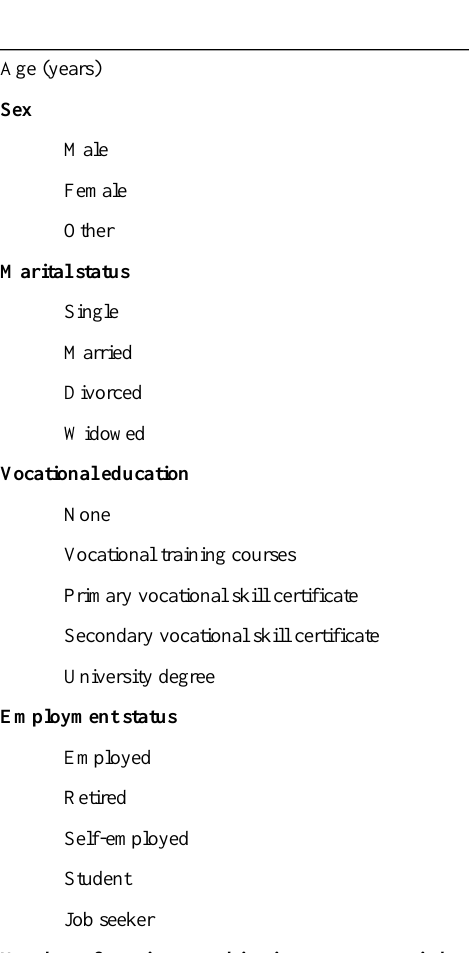
Table 1. Dummy table for background characteristics in intervention (short message service) and control groups at baseline. ControlInterventionCharacteristic